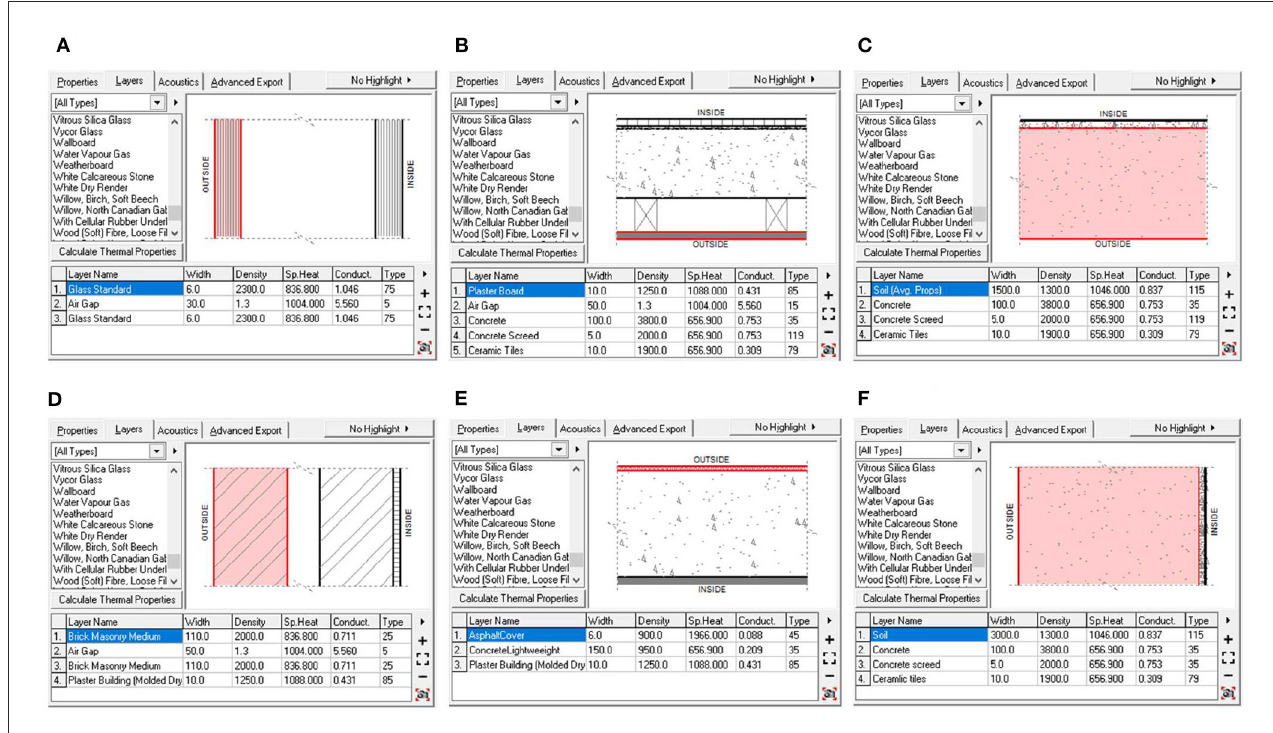
FIGURE3 Profile view of the material composition layer. Image source: self-drawn by the author. (A) DoubleGlazed_LowE_AlumFrame. (B) ConcFlr_Tiles_Suspended. (C) ConcSlab_Tiles_OnGround. (D) DoubleBrickCavityBlaster. (E) ConcreteRoof_Asphalt. (F) Underground wall.